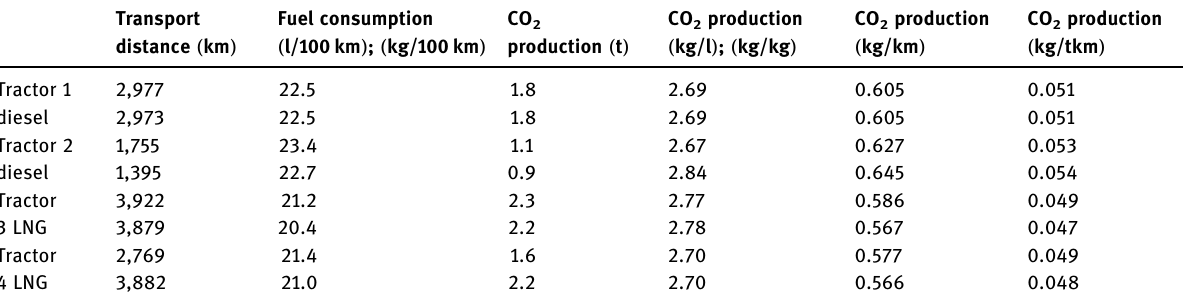
Table 2: CO 2 production from tractors with a semi - trailer on regular freight lines